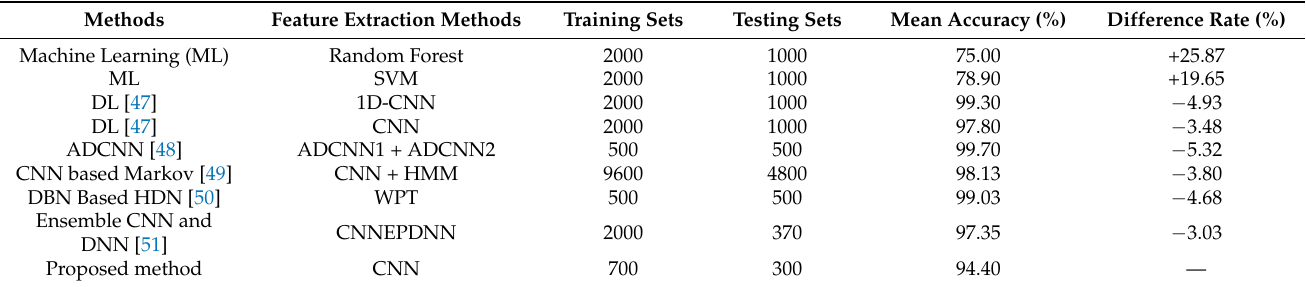
Table 5. Performance comparison of the model on the CWRU